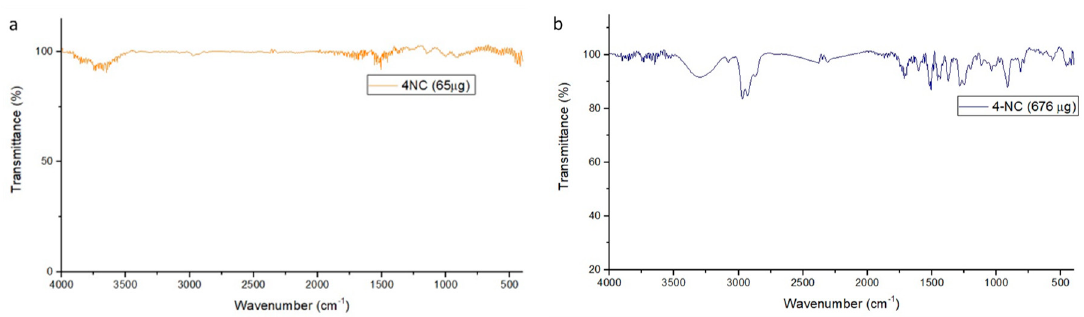
Figure 7. FT-IR spectra of 4-NC ( a ) 65 µ g ( b ) 676 µ g.